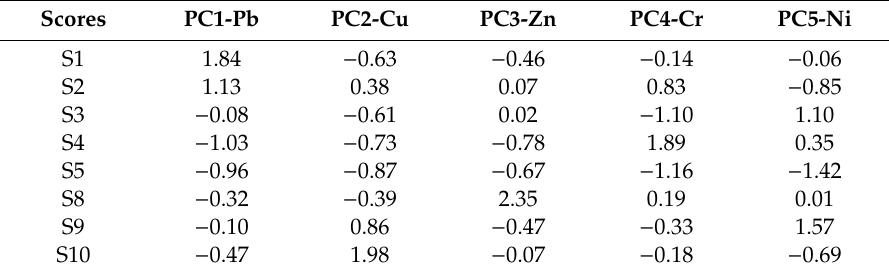
Table 5. Factor scores of the extracted principal